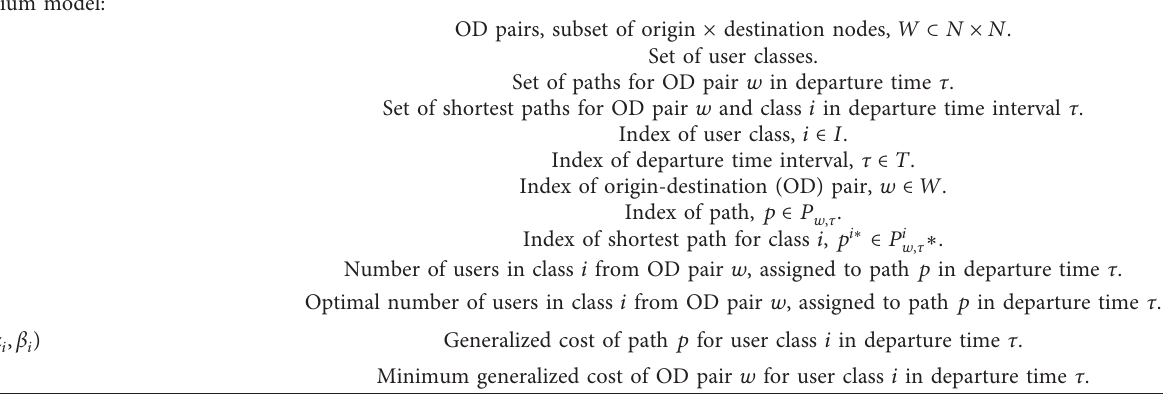
Equilibrium model: